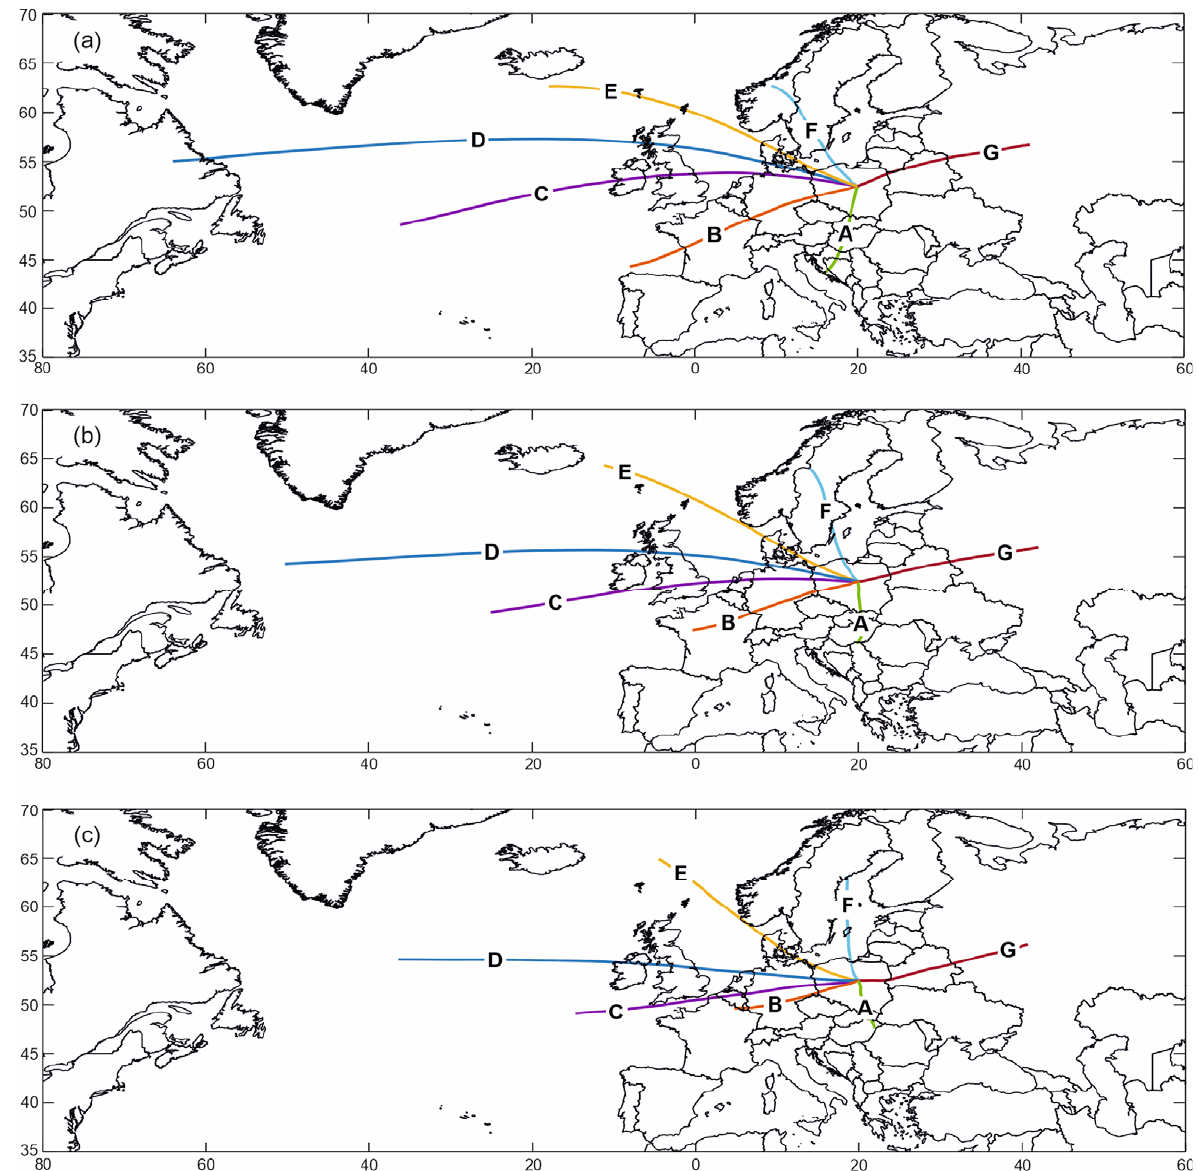
Figure 1. Averaged 72-h backward trajectories in 7 clusters ending at the grid point 52.5 ◦ N, 20 ◦ E at 12:00 UTC at the following heights: 3000 m above ground level ( a ), 1500 m above ground level ( b ), 500 m above ground level ( c ), during the period 1986–2015.